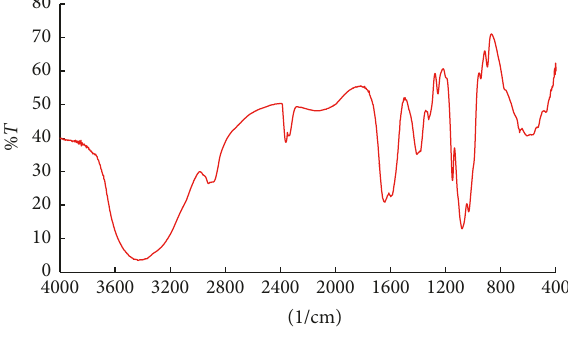
Figure 6: FTIR spectrum of CMC. Table 2: Analysis of new functional groups of CMC-benzaldehyde using FTIR.